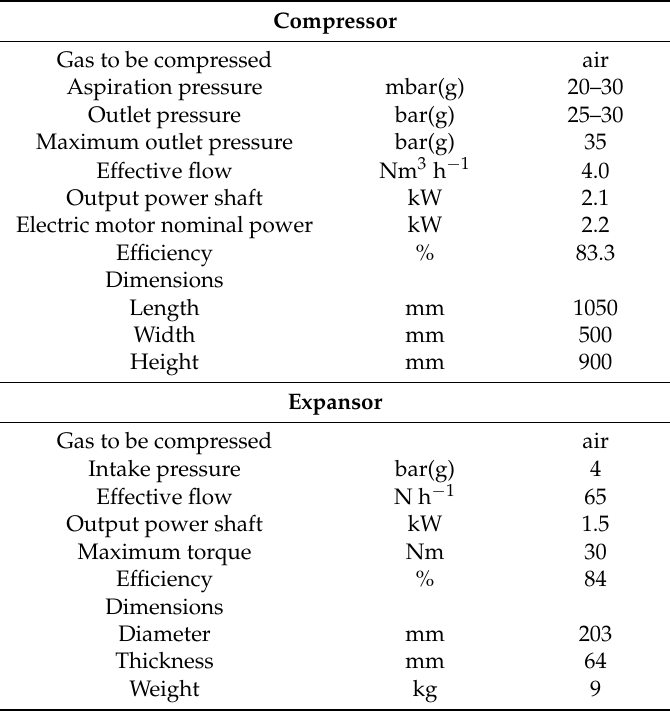
Table 1. Technical data of the experimental